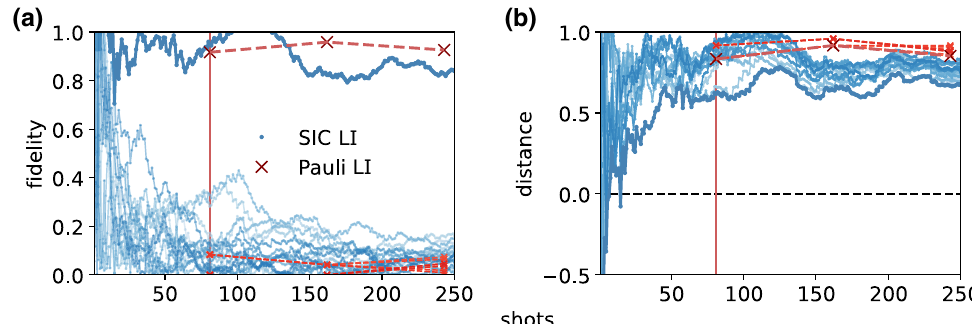
FIG. 11. Fast state identification from SIC tomography. Complementary analysis of the quantum game from Fig. 10. (a) Estimated fidelity with each of the 16 possible states. Via SIC tomography, we manage to identify the state with less than 20 shots, clearly under- cutting the smallest Pauli implementation using 3 4 = 81 shots. (b) For illustration purposes, we plot the fidelity difference between the generated state and all possible states as individual curves, which provides a distance measure. The minimum of these differences is used as a state distinguishability criterion to gain a reward; see the text for details.